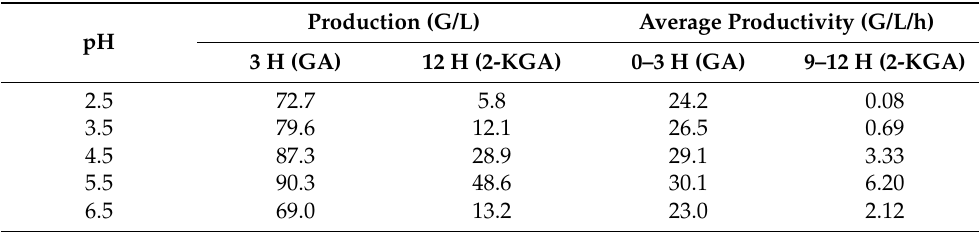
Table 1. Gluconic acid and 2-ketogluconic acid production by Gluconobacter oxydans in different pH